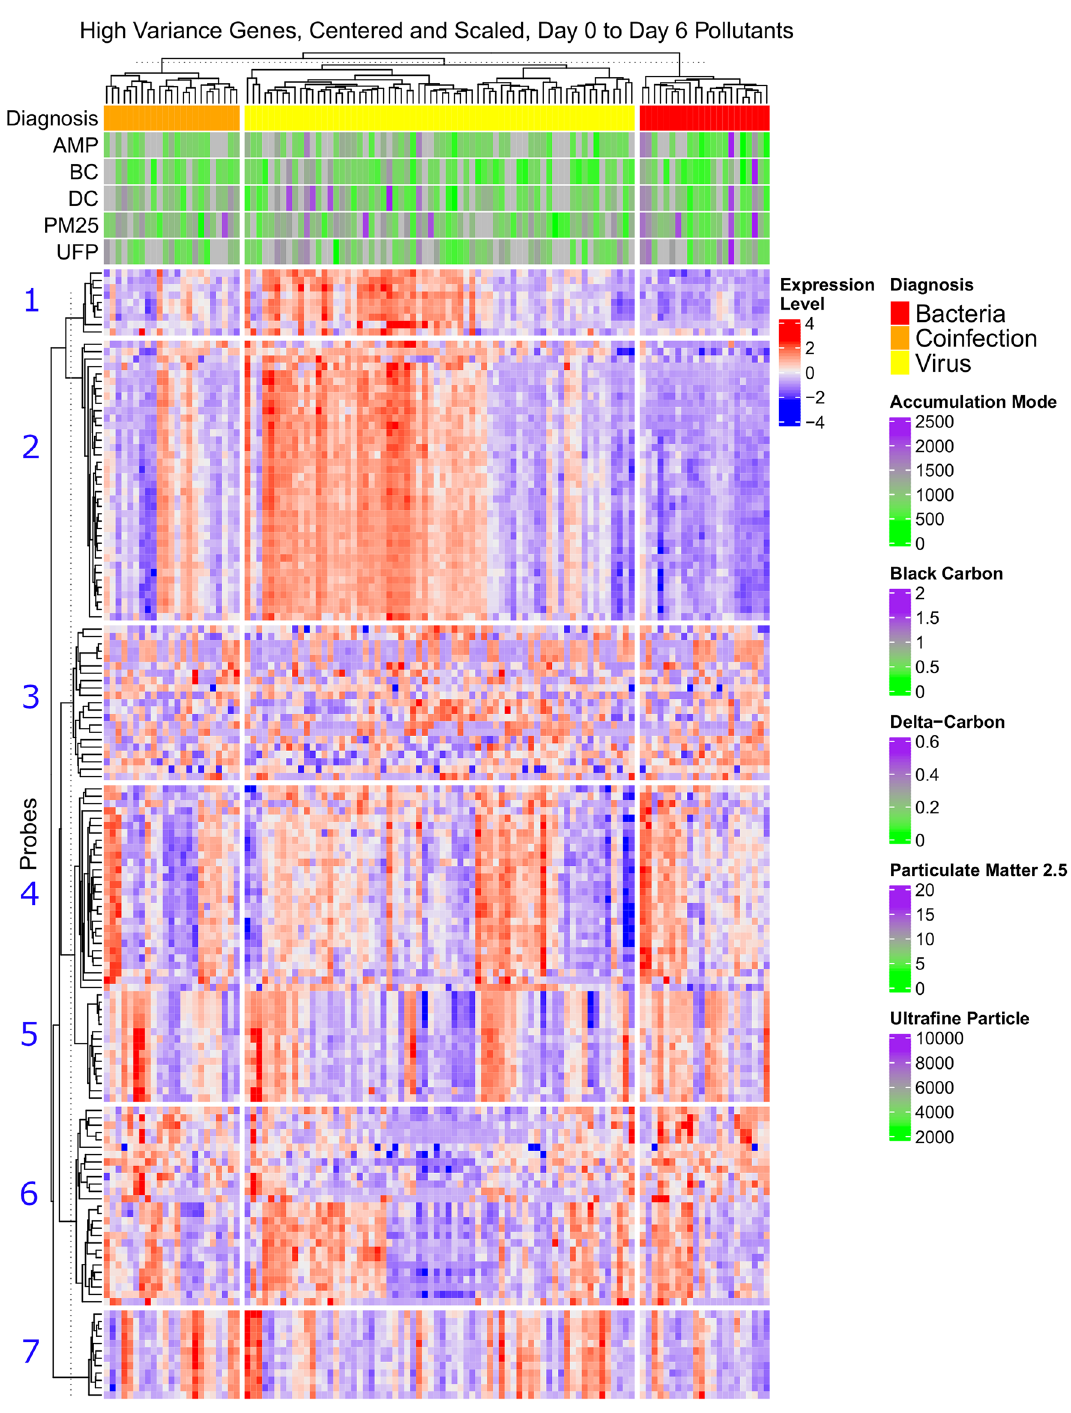
Figure 2. Heat map of the 150 highest variance genes and corresponding air pollution concentrations, stratified by type of respiratory infection and divided by participant (Columns) and gene cluster (Rows 1–7). The selected expression values were centered and scaled to have mean zero and variance one. The dendrograms were produced using hierarchical clustering on either genes or samples using Euclidean distance and complete linkage. A qualitative threshold (dotted line) was selected to define gene clusters based on the hierarchical